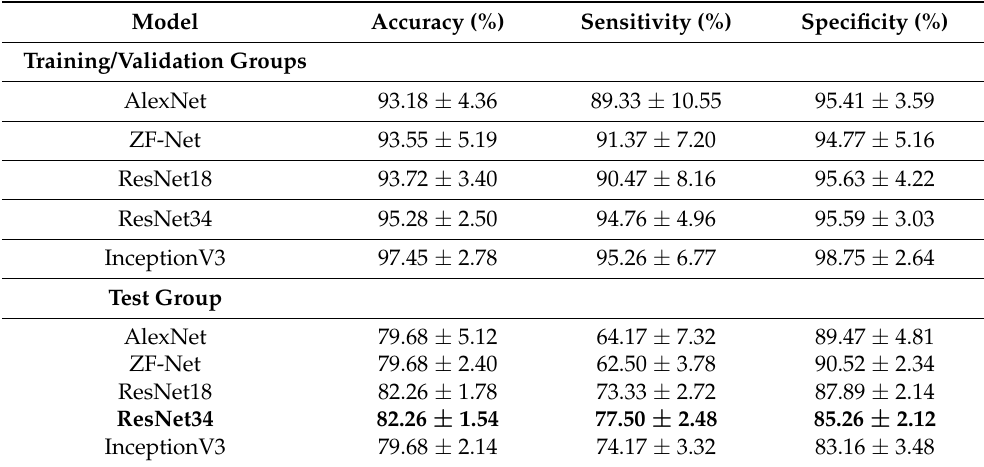
Table 3. Classification performance in MCI vs. AD.